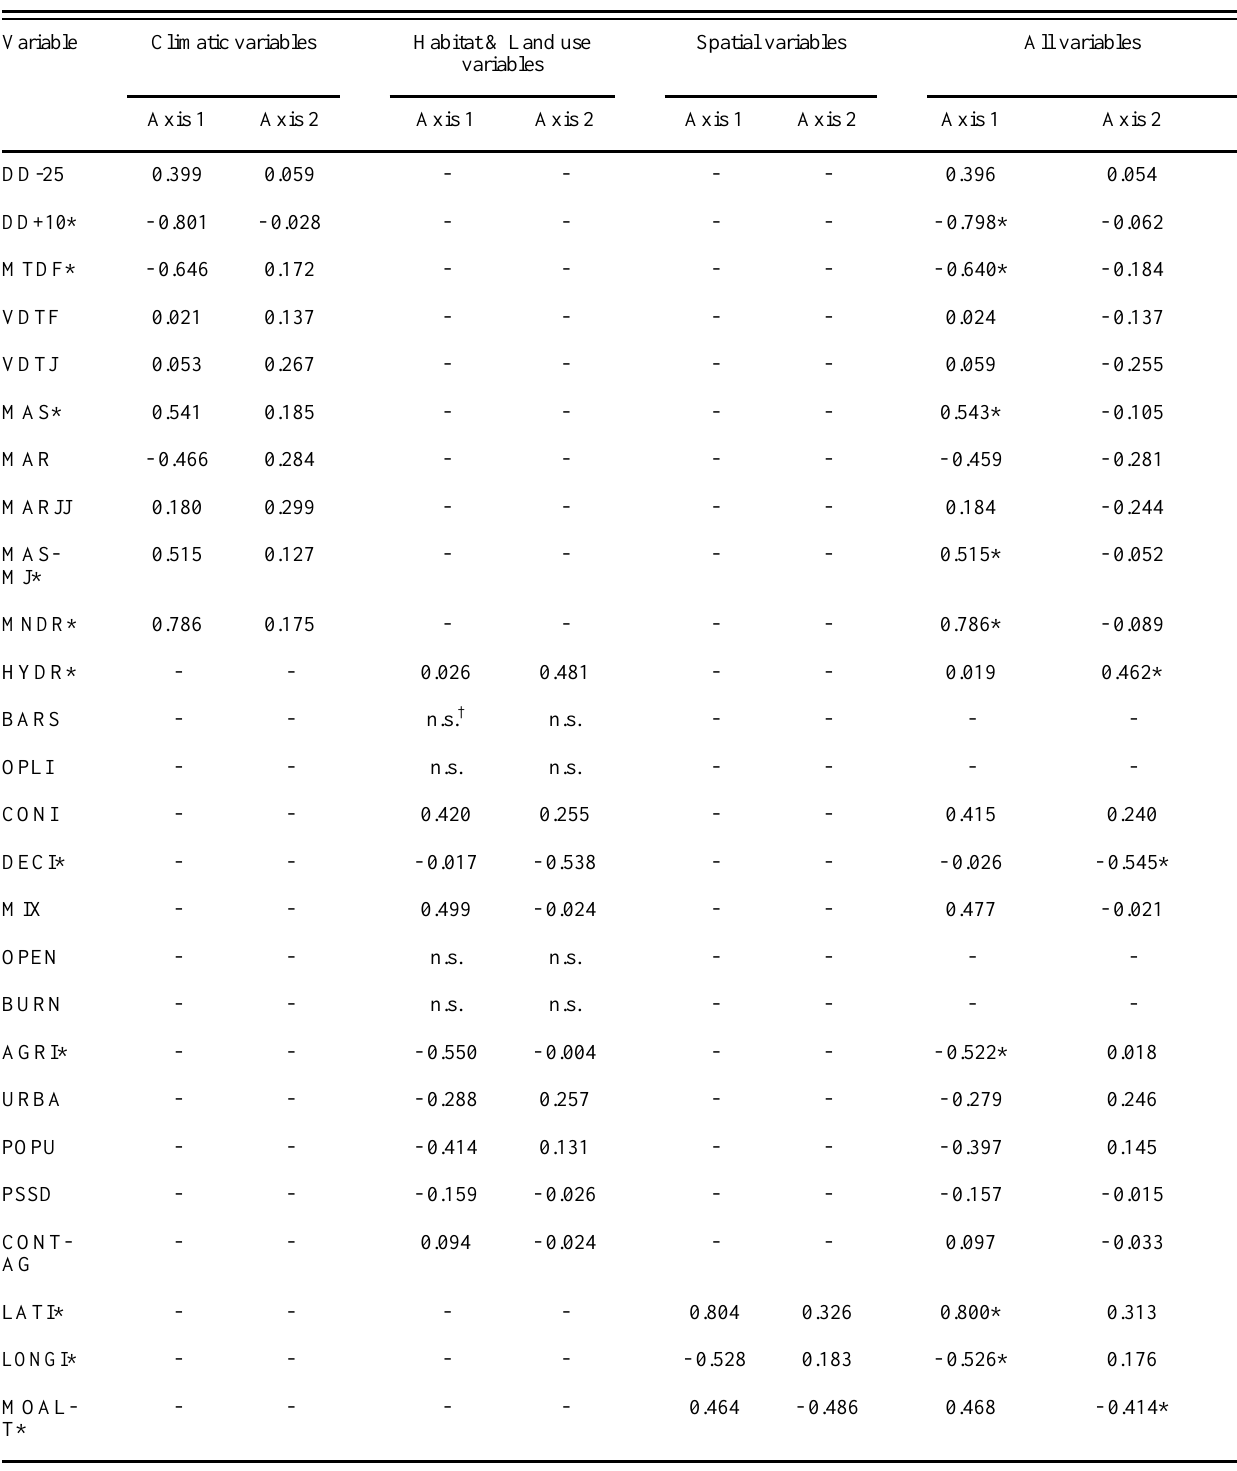
Table 4. Correlation coefficients of significant independent variables (p < 0.05), based on results for Axes 1 and 2 of four Canonical Correspondence Analyses